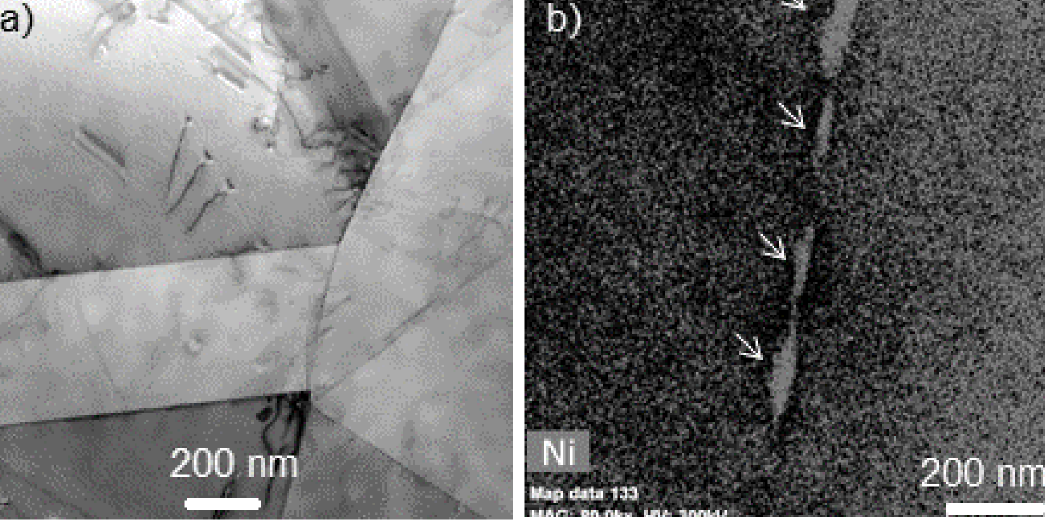
Figure 5. a) Absence of precipitates on twin boundaries in the alloy "without" beryllium. b) EDX map revealing nickel-rich precipitates, having the same structure as B precipitates, on the twin boundaries of the variant "with"